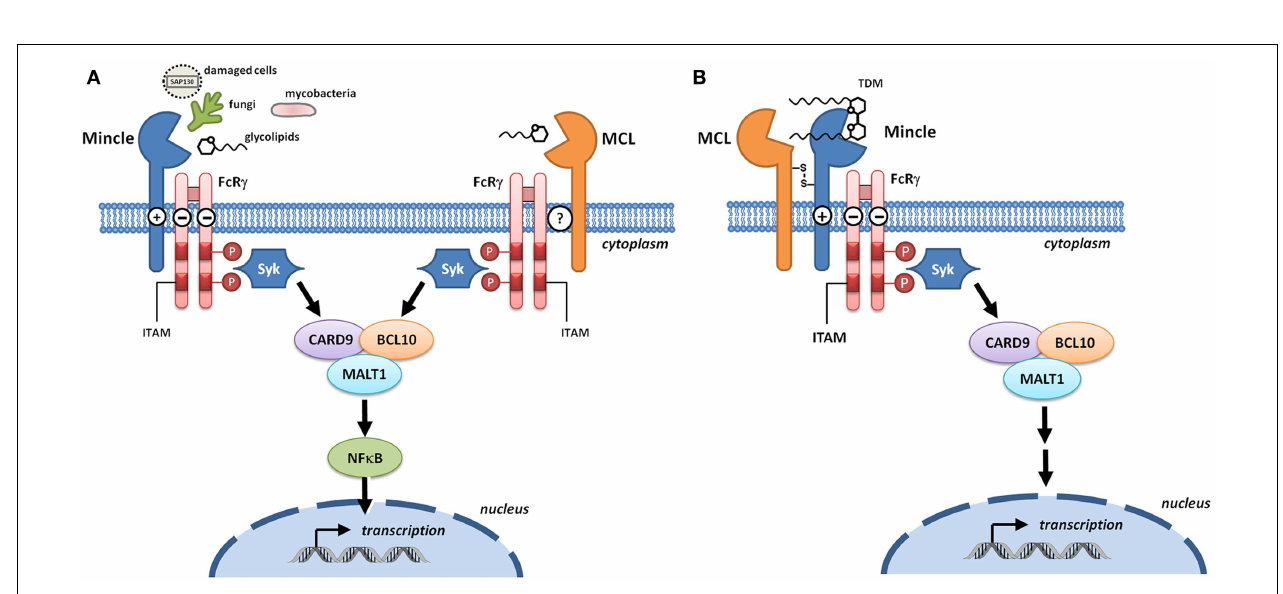
and induces signaling through the Card9–Bcl10–MALT1 complex. Transcription results in the formation of immunoregulatory cytokines and chemokines. (B) Heterodimers of MCL and Mincle have the capacity to sense trehalose dimycolate (TDM). In these complexes,